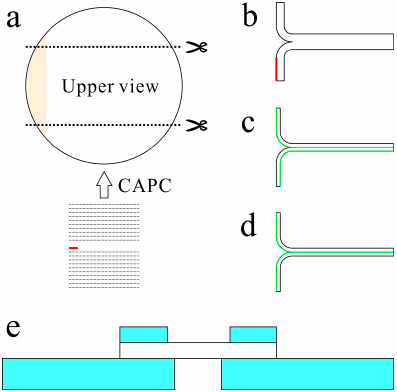
Figure 9. Sample preparation for the peel and penetration tests. ( a ): Cutting point for peel test, ( b ): edge-widened sample for peel test, ( c ): reference sample (one-sided adhesive surface) for peel test, ( d ): reference sample (dual-sided adhesive surface) for peel test, and ( e ): sample sandwiched between steel plates for penetration test.